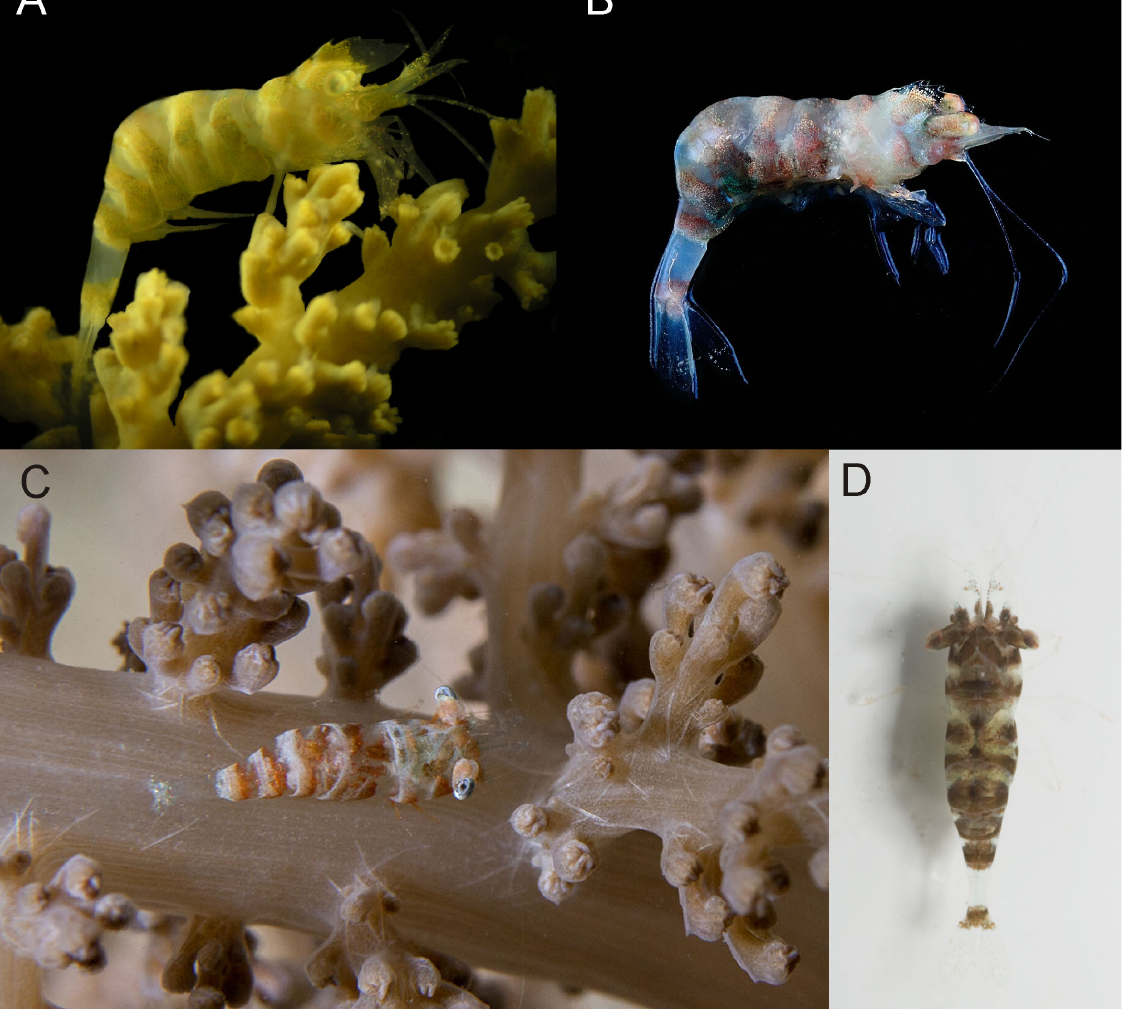
Fig. 10. Colour pattern of three relatives of the genus Hamodactylus . — A . H. aqabai Bruce & Svoboda, 1983, ovigerous ♀ (UO Aq09-55) on alcyonacean coral Nephthea sp., Aqaba, Red Sea. — B–C . H. paraqabai sp. nov., ovigerous ♀♀, Madang, Papua New Guinea, on Nephthea sp. B . Holotype (MNHN-IU-2013-11092). C. Paratype (MNHN-IU-2013-11090). — D . H. pseudaqabai sp. nov., ovigerous ♀, holotype, N. Sulawesi, Indonesia (RMNH.CRUS.D.57195). Photos: Z. Ďuriš (A), T.- Y. Chan (B), A.F. Berberian (C), C.H.J.M. Fransen